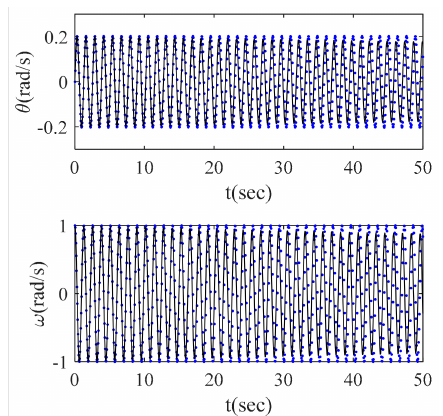
Figure 5. Comparison of 4th order Runge–Kutta and difference